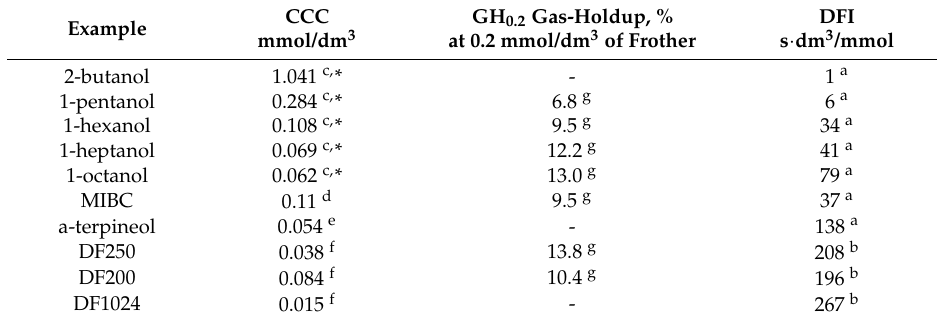
Figure 5. Determination of CCC, CCC 95 and CCC t from the relation between average bubble size and frother concentration. Table 11. Classification of frothers according to their values of CCC, DFI and GH 0.2 . Source of data: